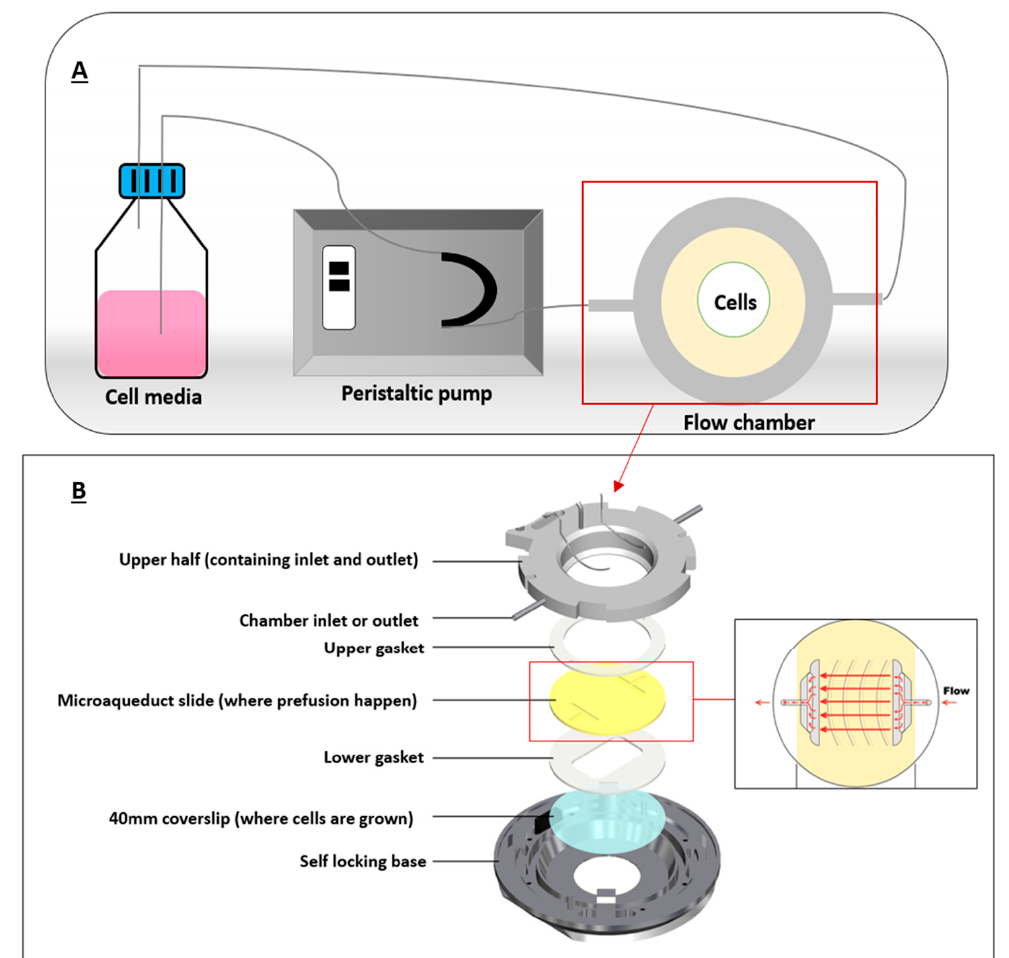
Figure 4. A typical flow chamber setup. ( A ) depicts a closed-circuit chamber, in which the chamber is connected to a peristaltic pump and a reservoir (cell media). ( B ) illustrates the flow chamber assembly where coverslip containing the cells is allowed for fluid flow. Adapted from bioptechs [42].